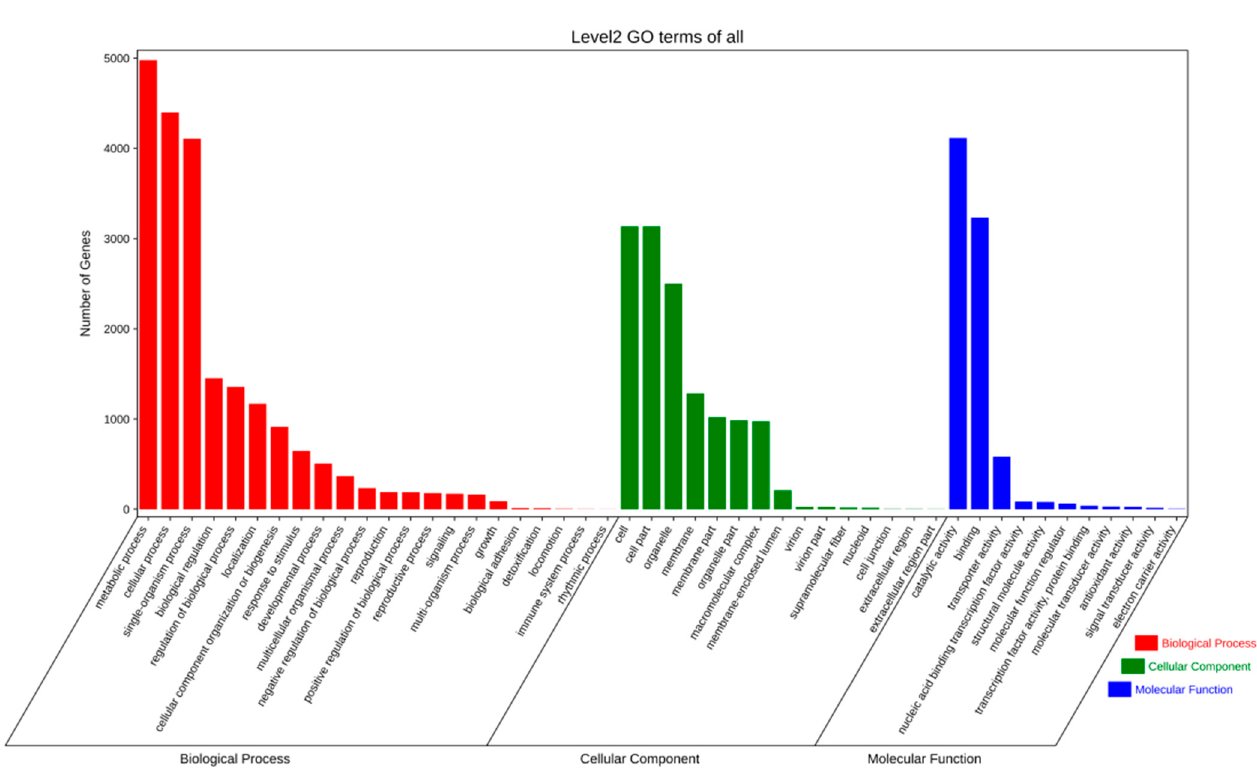
Figure 6. GO functional annotation of strain SX13.